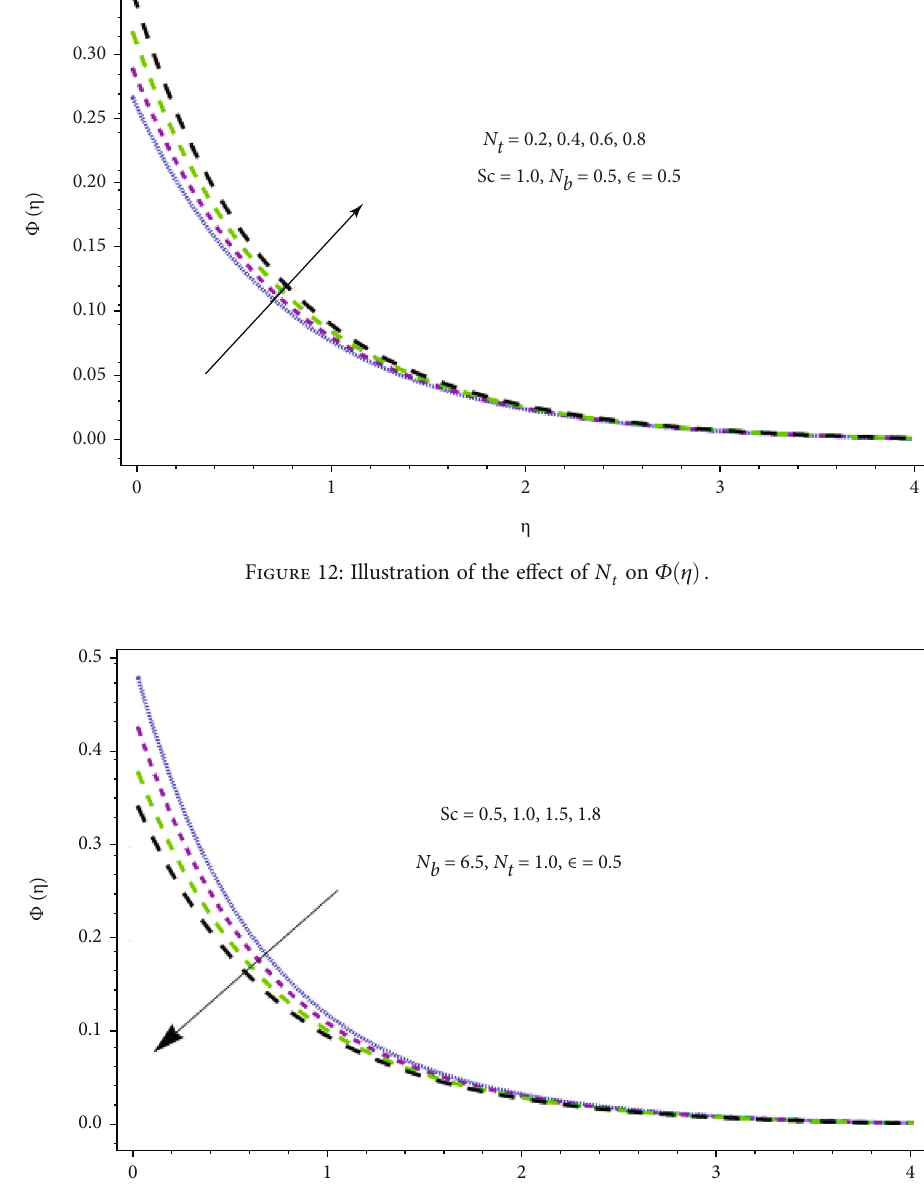
Figure 13: Representation of the e ff ect of Sc on Φ ð η Þ